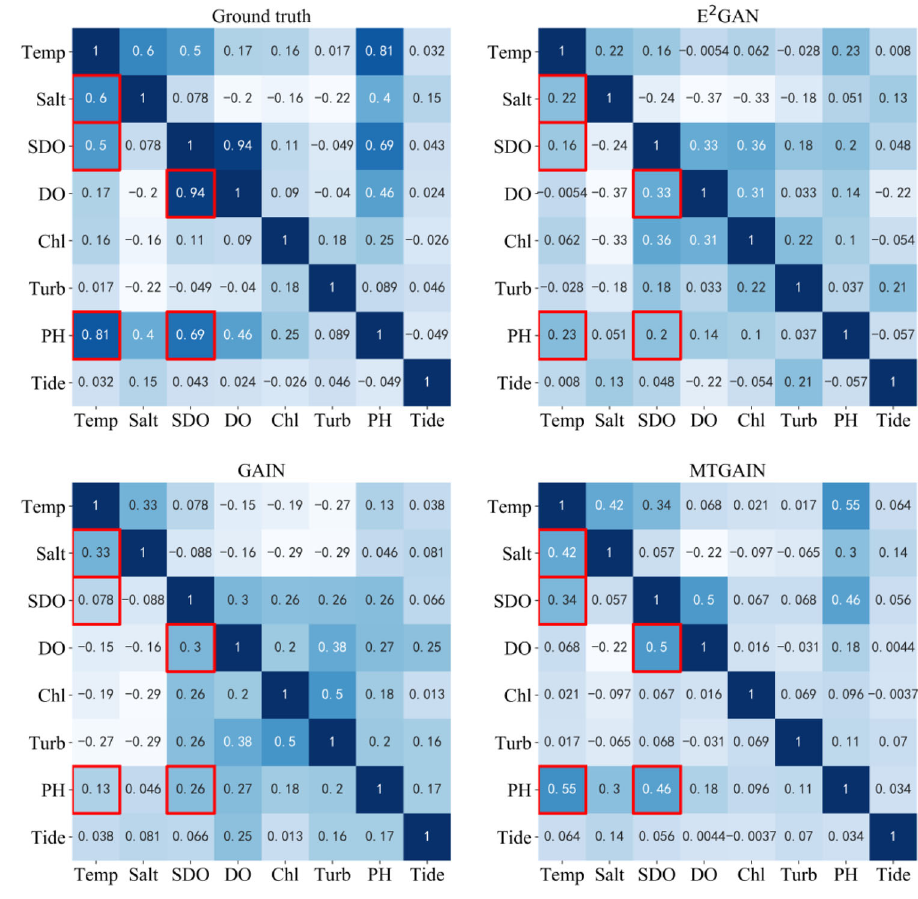
Fig. 6 The PCCs between different attributions reconstructed by different methods under 70% missing